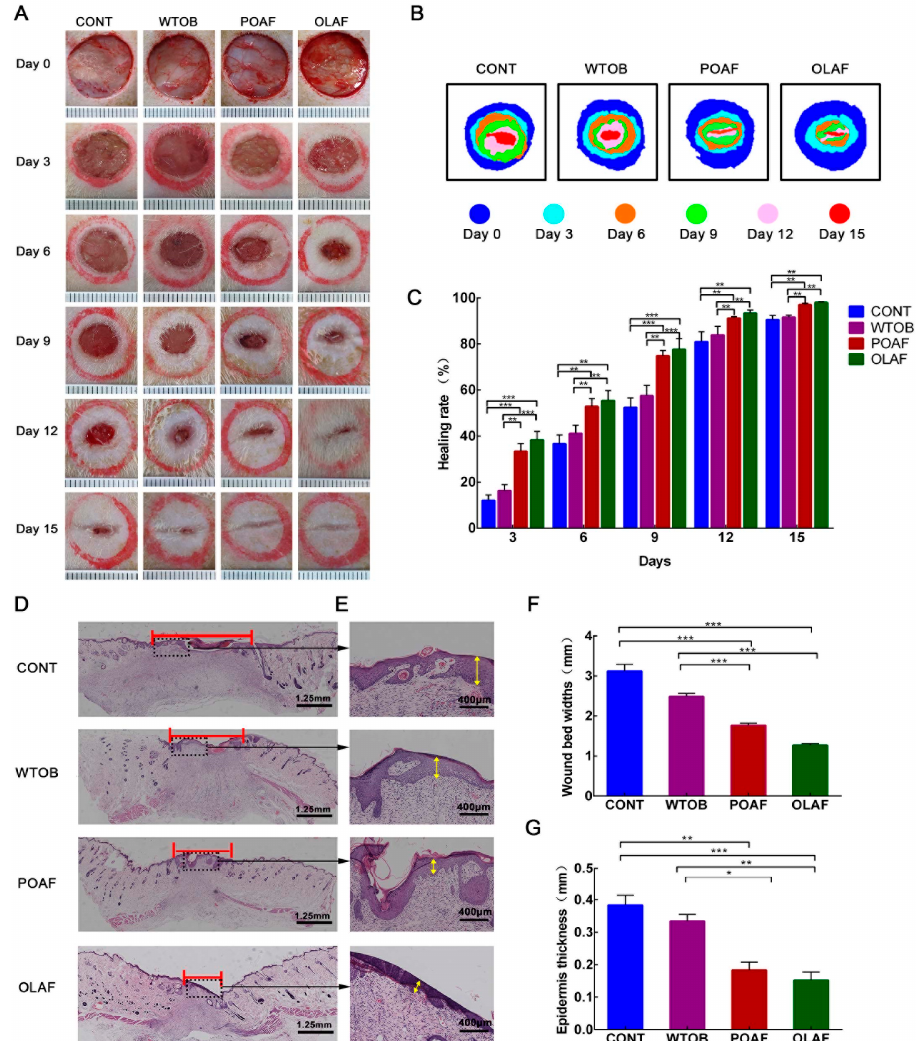
Figure 1. Transdermal treatment with oleosomes fused with human fibroblast growth factor 1 (OLAF) promoted wound repairing in rats with a full-thickness skin defect. ( A ) Macroscopic view of wound sites treated with test substances over 15 days. ( B ) Heat maps were introduced to simulate the changes in the wound closure. ( C ) Quantitative analysis of the wound healing rates of the different groups. ( D ) Histological diagrams of wound sections stained with H&E on day 15 and their enlarged images, where the margin of the wound is indicated by the red line. ( E ) Higher magnification of black dotted squares for observing the epidermal thickness, which is indicated by the yellow arrow. ( F , G ) Quantification of the wound bed widths and epidermal thickness. * p < 0.05, ** p < 0.01, *** p < 0.001. All obtained data are displayed in the form of mean ± SD (n =